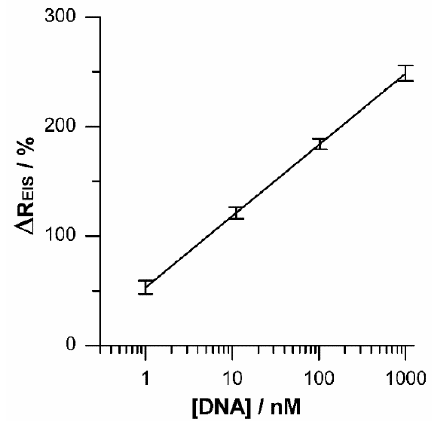
Figure 8. The logarithm relationship between ∆ R EIS and target DNA concentration with the new equivalent circuit.